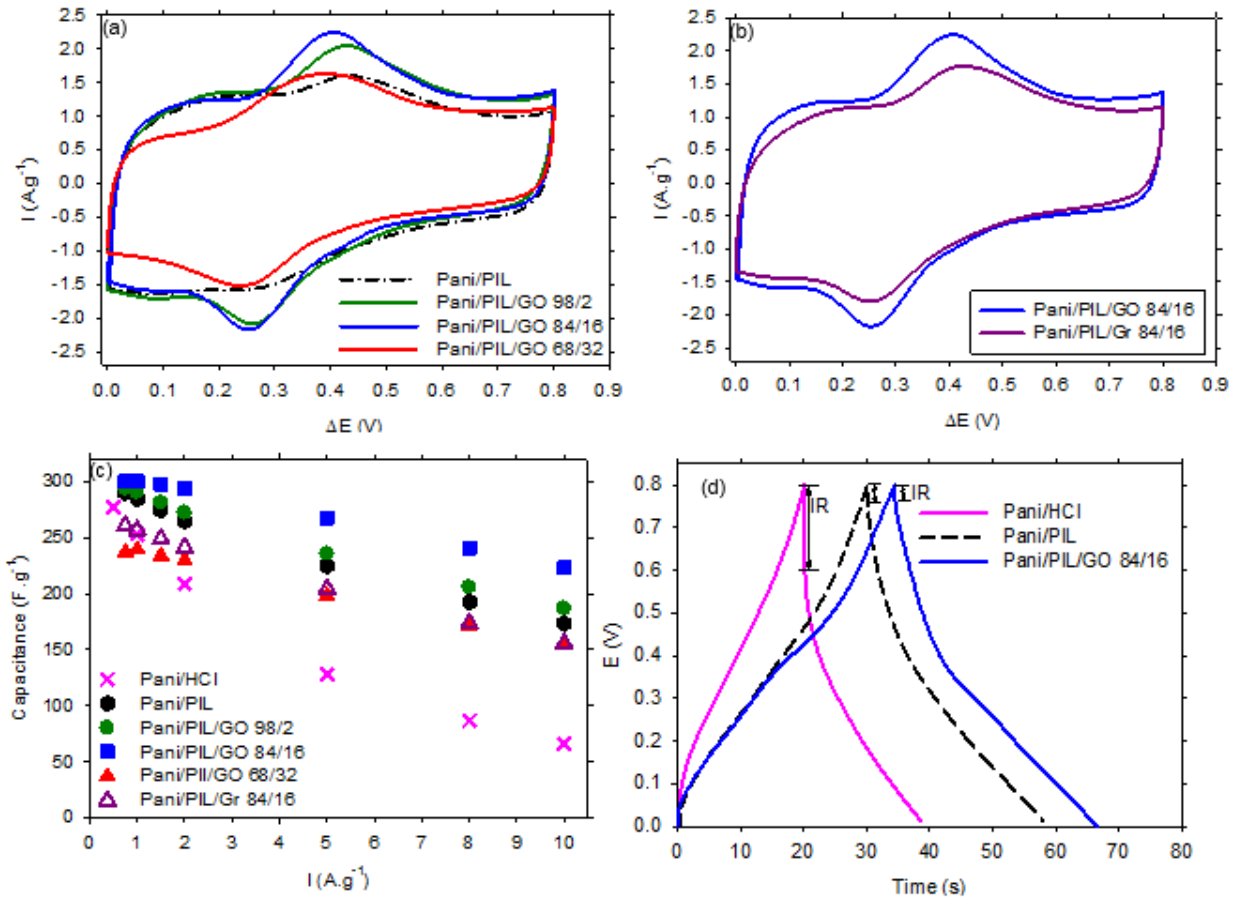
Figure 5. Cyclic voltamograms at 15 mV · s − 1 of ( a ) PANI/PIL and PANI/PIL/GO (98/2, 84/16 and 68/32) and ( b ) PANI/PIL/GO 84/16 and PANI/PIL/Gr 84/16 nanocomposites in H 2 SO 4 1 mol · L − 1 , ( c ) the specific capacitance at different current densities of all the investigated electrodes, and ( d ) the charge discharge curves at 2 A · g − 1 of PANI/HCl, PANI/PIL, and PANI/PIL/GO 84/16 .